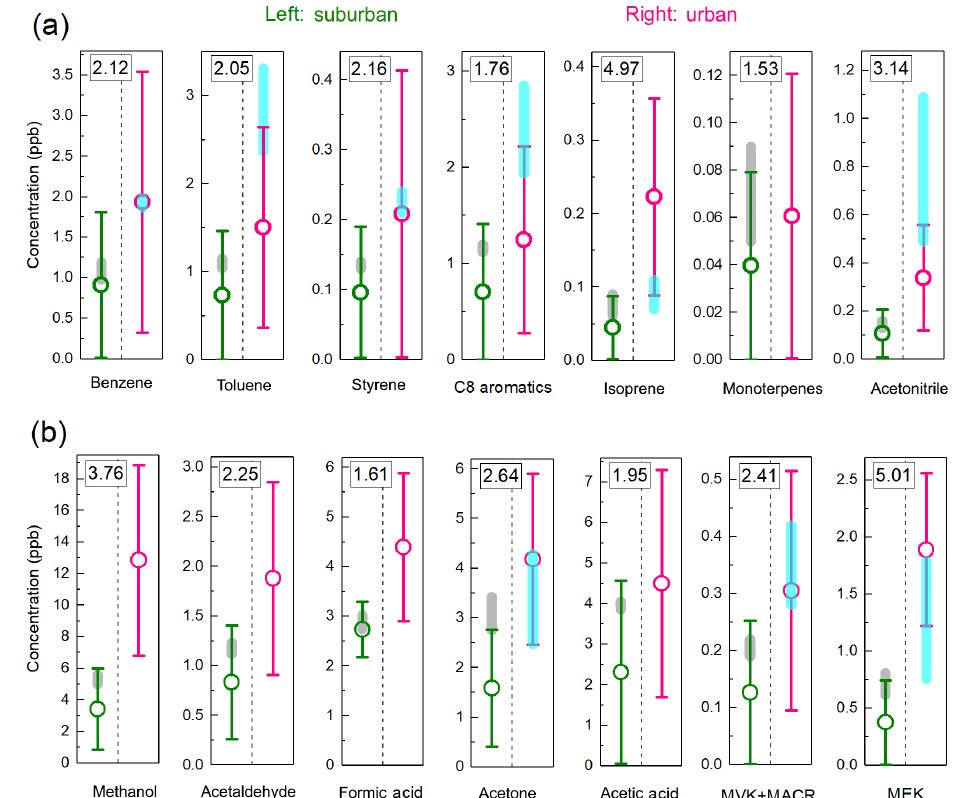
Figure 3. Suburban and urban VOC average concentrations: (a) hydrocarbons and acetonitrile; (b) OVOCs. The circles are VOC concen- trations of this work, of which the urban concentration is from the period I data to avoid any holiday effects. The number at the top is the ratio between urban and suburban average concentrations. The shaded areas are non-APEC average concentrations from previous studies carried out in 2014 autumn at suburban (K. Li et al., 2017) and urban (Li et al., 2015) sites. Note that a factor of 0.22 is applied to m/z 69 for isoprene in this study and in a previous study by PTR-MS (K. Li et al.,